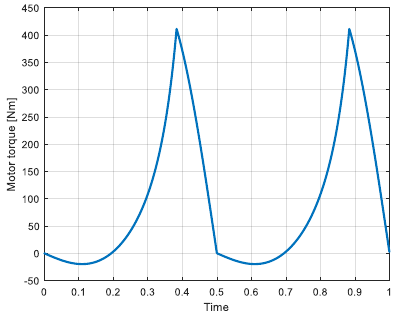
Figure 12. Torque developed (crank shaft) (Nm).